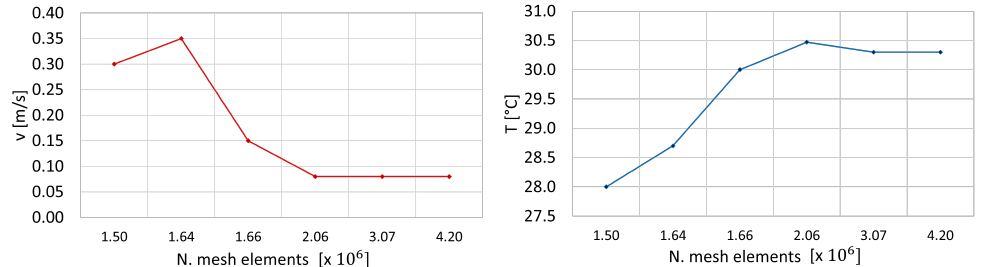
Figure 2. Velocity and temperature values in one point obtained for the five different grids.